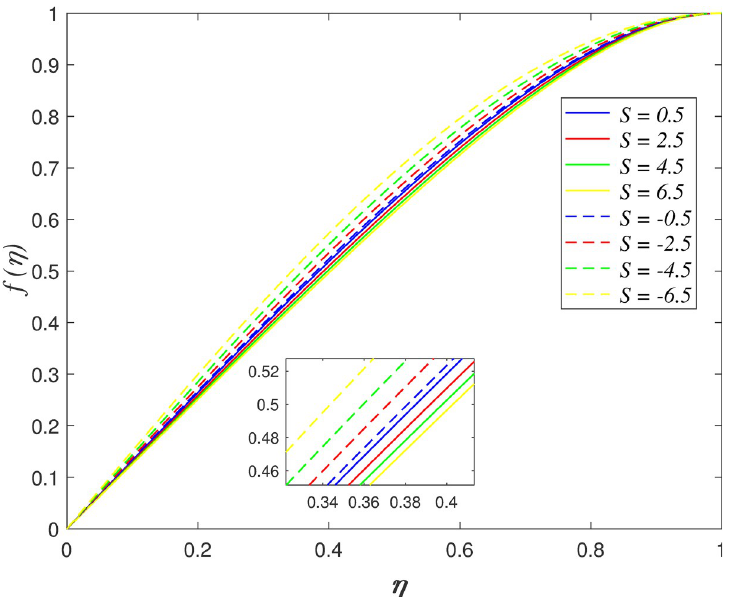
Fig 2. Impact of S on radial velocity.